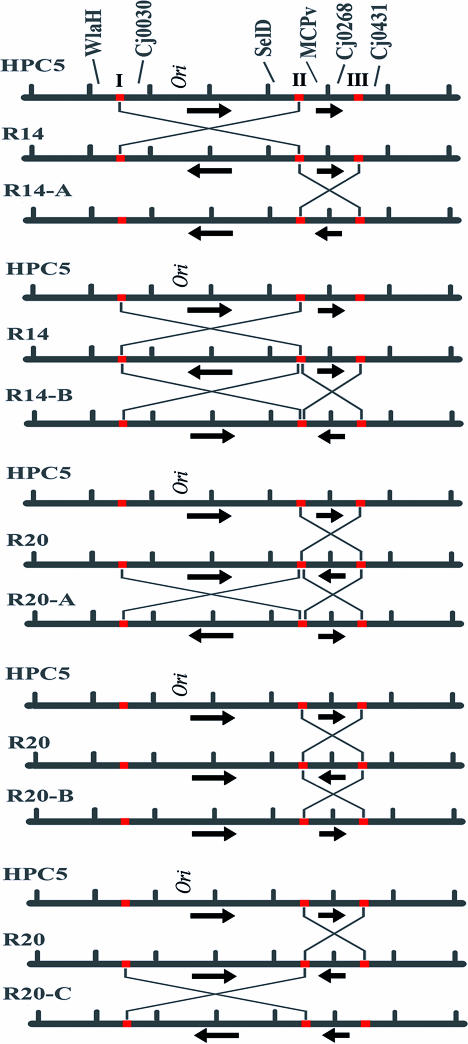
Rearrangements Involved in Altering Sensitivity to BacteriophageDiagrammatic representation of the rearrangements involved in generating the genome configurations of the R14 and R20 revertant strains. The lineage of each of the five revertant strains is traced from C. jejuni HPC5. The locations of the CampMu prophage used as the recombination substrates are indicated in red and the direction of the variable genome segments are indicated by arrows relative to the parent strain HPC5. The identity of each prophage is indicated by I, II, and III. SmaI sites are indicated as vertical lines. This diagram is not to scale. Southern hybridisations of the PFGE of SmaI-digested C. jejuni genomic DNAs of R14, R20, and their derivatives can be found in Figure S2.